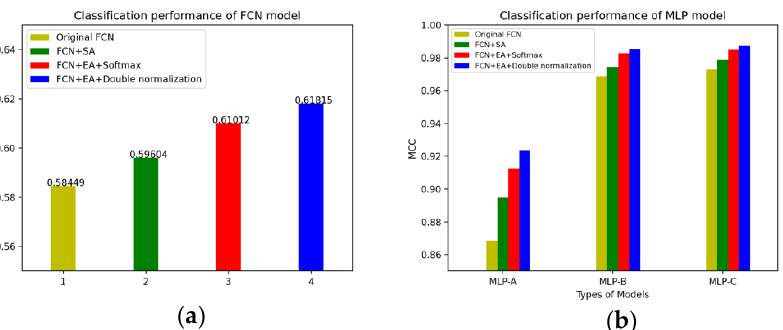
Figure 12. ( a ) The changes of the FCN models’ accuracy; ( b ) The changes of the MLP models’ accuracy.